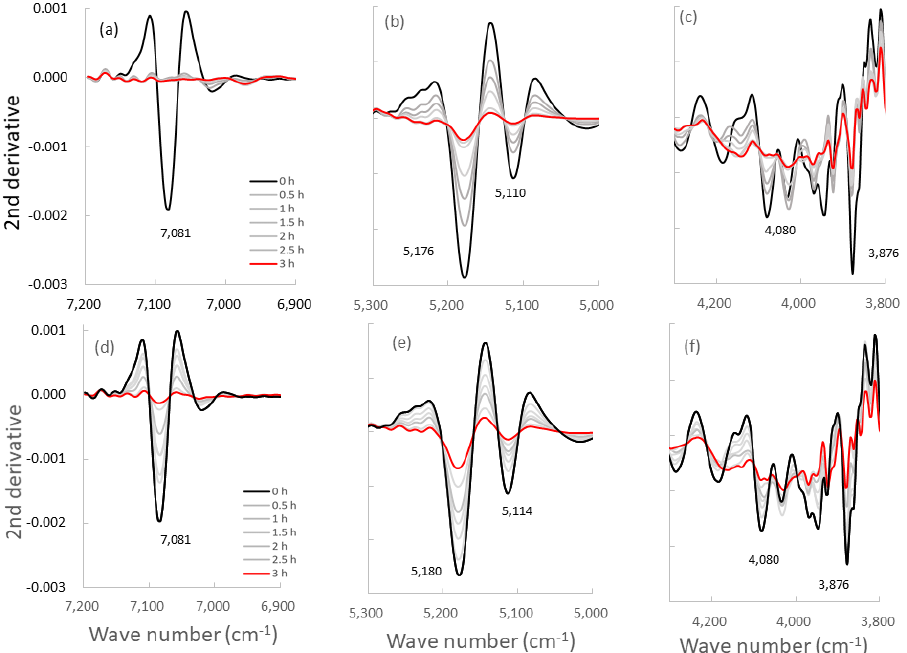
Figure 6. Second-derivative NIR spectra of the ground S-CP products obtained at various grinding times. ( a – c ): second-derivative spectra of the products obtained by wet grinding; ( d – f ): spectra of the products obtained by dry grinding; The spectra are at wavelengths of approximately ( a , d ) 7000, ( b , e ) 5000, and ( c , f ) 4000 cm − 1 .